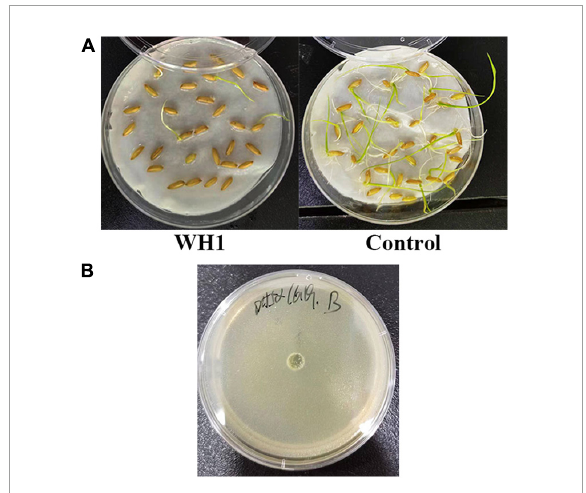
FIGURE10 Phytotoxins production by Dickeya zeae strain WH1. (A) Inhibitory activity of toxins from D. zeae strain WH1 against rice seeds germination; (B) the WH1 culture did not inhibit the growth of Escherichia coli DH5 α